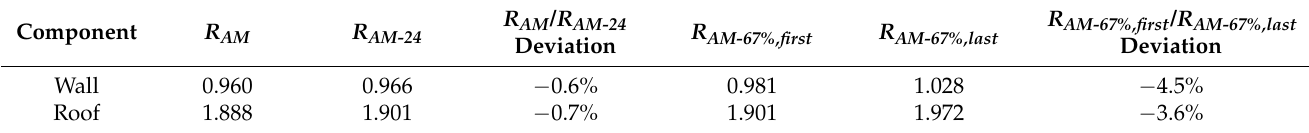
Table 1. Convergence conditions.